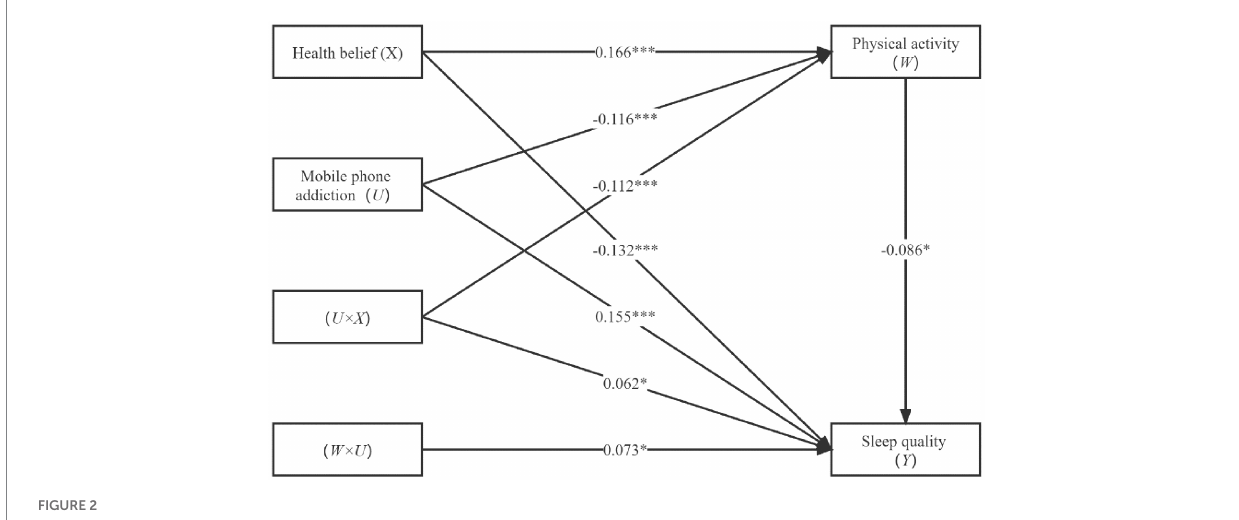
FIGURE 2 Moderated mediation model.